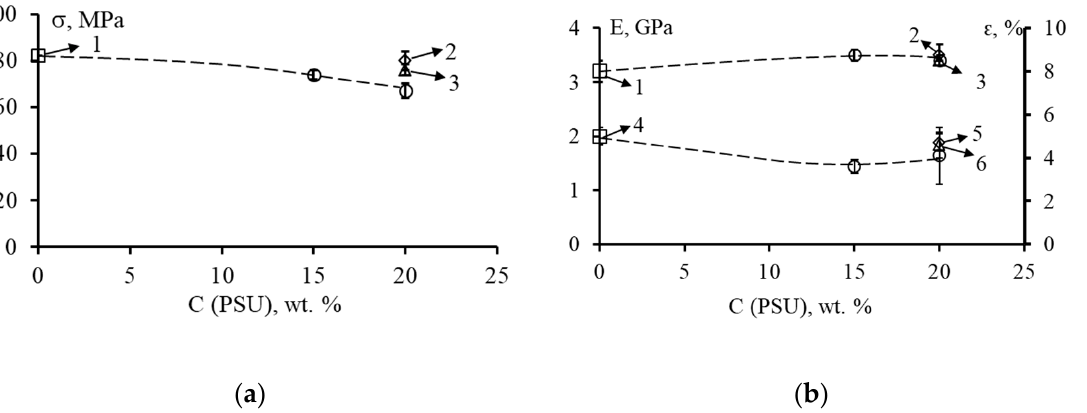
Figure 4. Strength σ , elastic modulus E and relative elongation ԑ at tension of epoxy systems EO + 20 wt. % of FGE, cured by TEAT, depending on the content of FGE: ( a ) 1–P0/F0, 2–P20/F0, 3–P20/F10; ( b ) 1 and 4–P0/F0, 2 and 5–P20/F0, 3 and 6–P20/F10. In ( b ) the upper curve corresponds to the modulus of elasticity, the lower curve corresponds to the relative elongation.